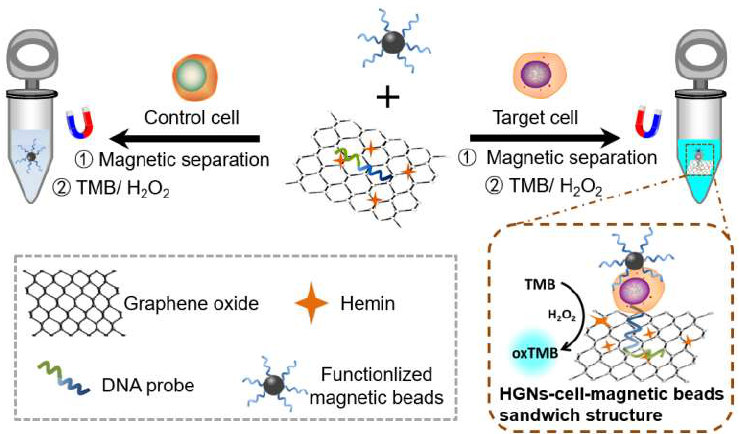
Figure 1. Schematic illustration of the principle for the detection of leukaemia cells based on hemin– graphene nanocomposites (HGNs) and magnetic enrichment.